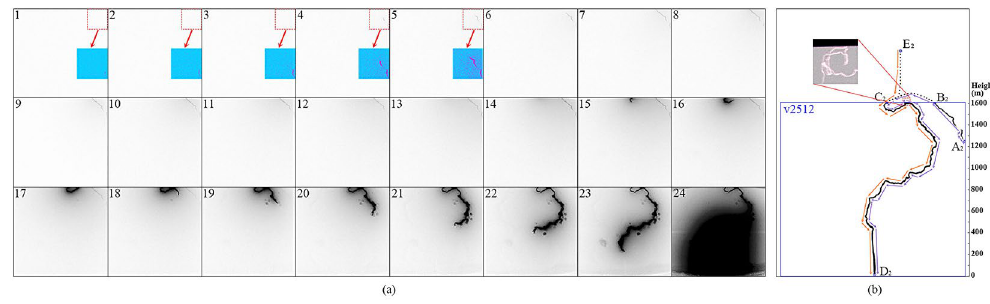
Figure 3. The illustration of the path along which the chasing leader II propagated and the speculative structure of the channel out of the high-speed camera’s FOV. ( a ) A sequence of cropped high-speed frames showing the propagation of Dart leader 8, with background removed, intensity inverted, and contrast enhanced. Some areas in Frames 1 to 5 were colored with contrast further enhanced. ( b ) A processed frame showing the path for the leaders. The blue rectangle indicates the high-speed camera’s FOV, the orange arrows indicate the path of the chased leader II, and the purple arrows indicate the path of the chasing leader II. A photo with higher image resolution recording the twisted portion of the channel is